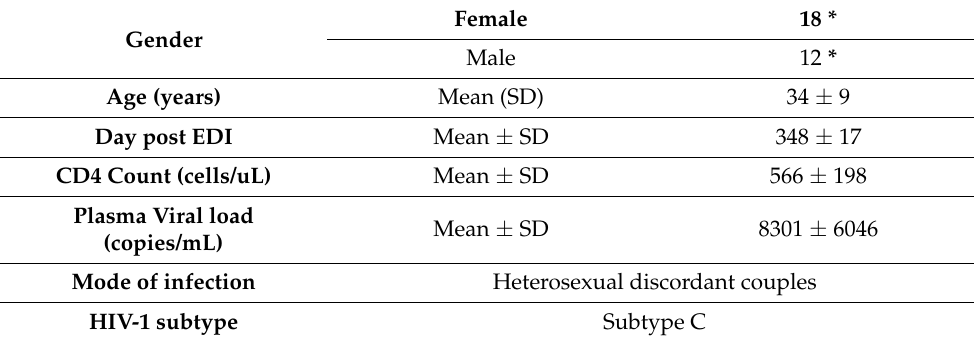
Table 1. Participants